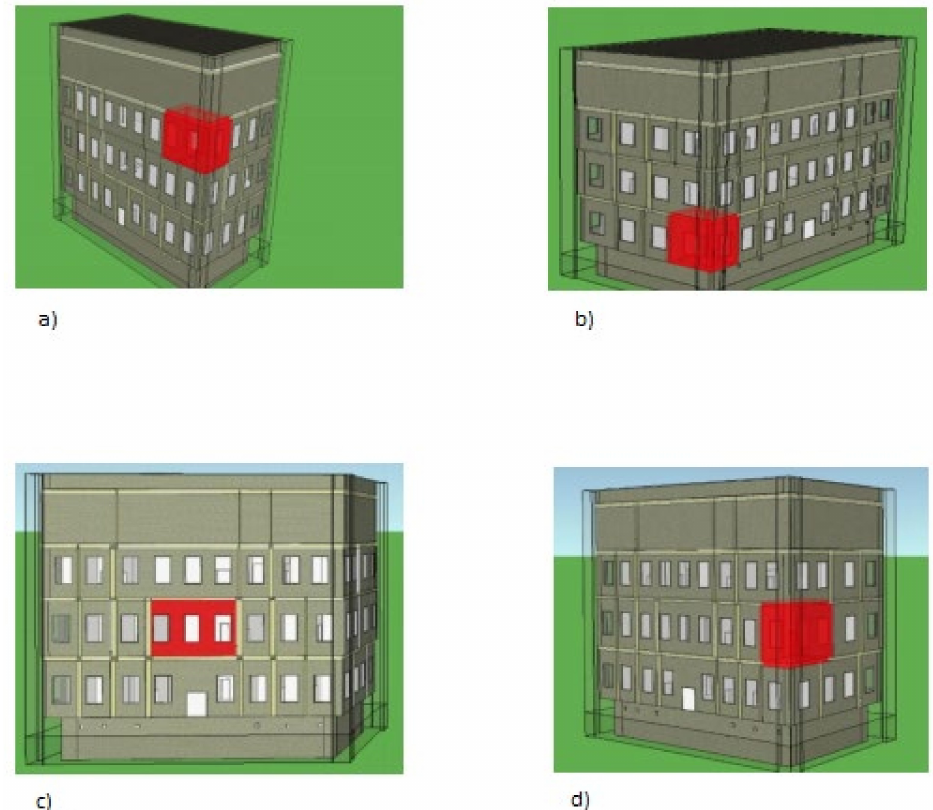
Figure 8. Position of the selected indoor zones for thermal comfort investigation: ( a ) zone 4 facing north-west and southwest; ( b ) zone 14 facing southwest and southeast; ( c ) zone 44 facing southeast; ( d ) zone 56 facing northeast and southeast. Table 8. Number of occupants and units of equipment in each zone. Zone Number of